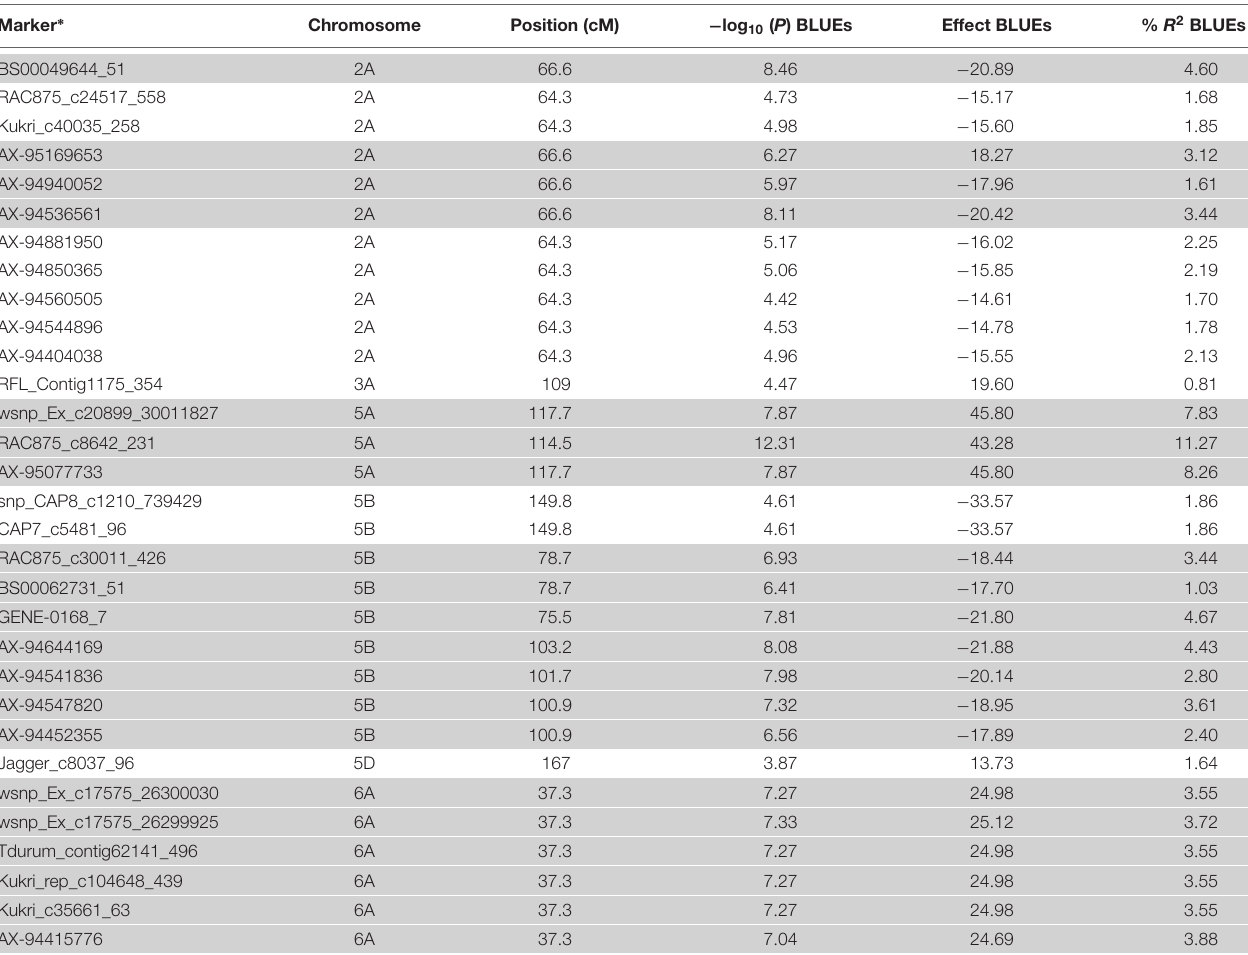
TABLE 1 | Summary of consistently significant markers detected in the two environments and